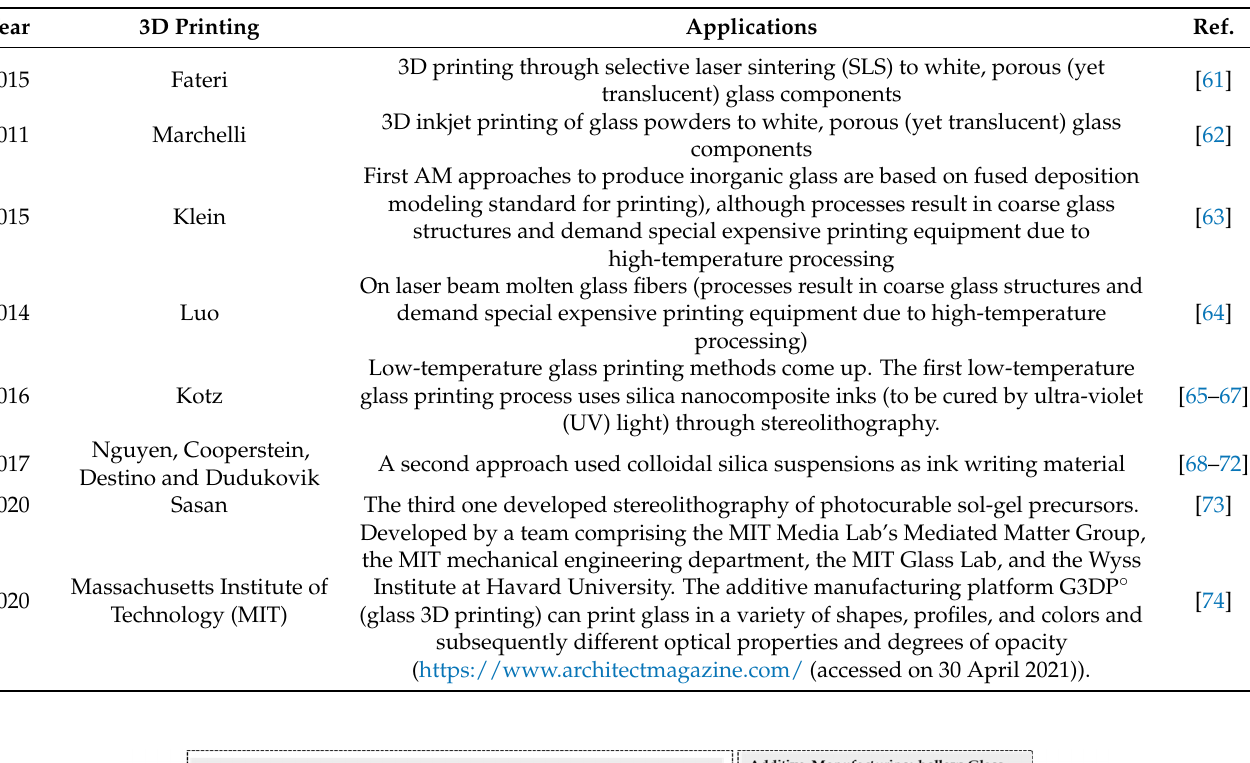
Table 3. Breakthrough in AM glass technologies (fourth generation on glass fabrication).